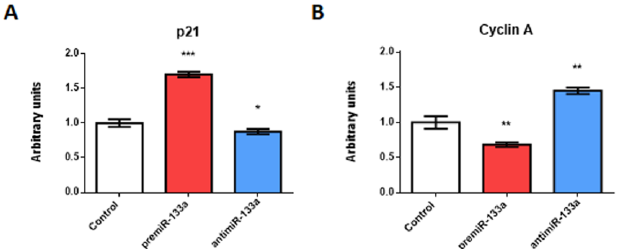
Figure 4. Effect of miR-133a gain- and loss-of-function experiments on cellular proliferation during posterior differentiation of cardiac tube. RT-qPCR of RNA from dissected cardiac asa in embryos microinjected either with CFDA, premiR-133a or anti-miR-133a, at the level of the posterior cardiac precursors of both primitive endocardial tubes. Note that miR-133a treatment leads to increased p21 ( A ) and decreased cyclin A ( B ) transcripts, whereas miR-133a inhibition leads to decreased p21 ( A ) and increased cyclin A ( B ) transcripts. The standard deviations are from three independent experiments. Student’s t -test: * p < 0.05, ** p < 0.01, *** p < 0.005 with respect to control (CFDA) embryos.